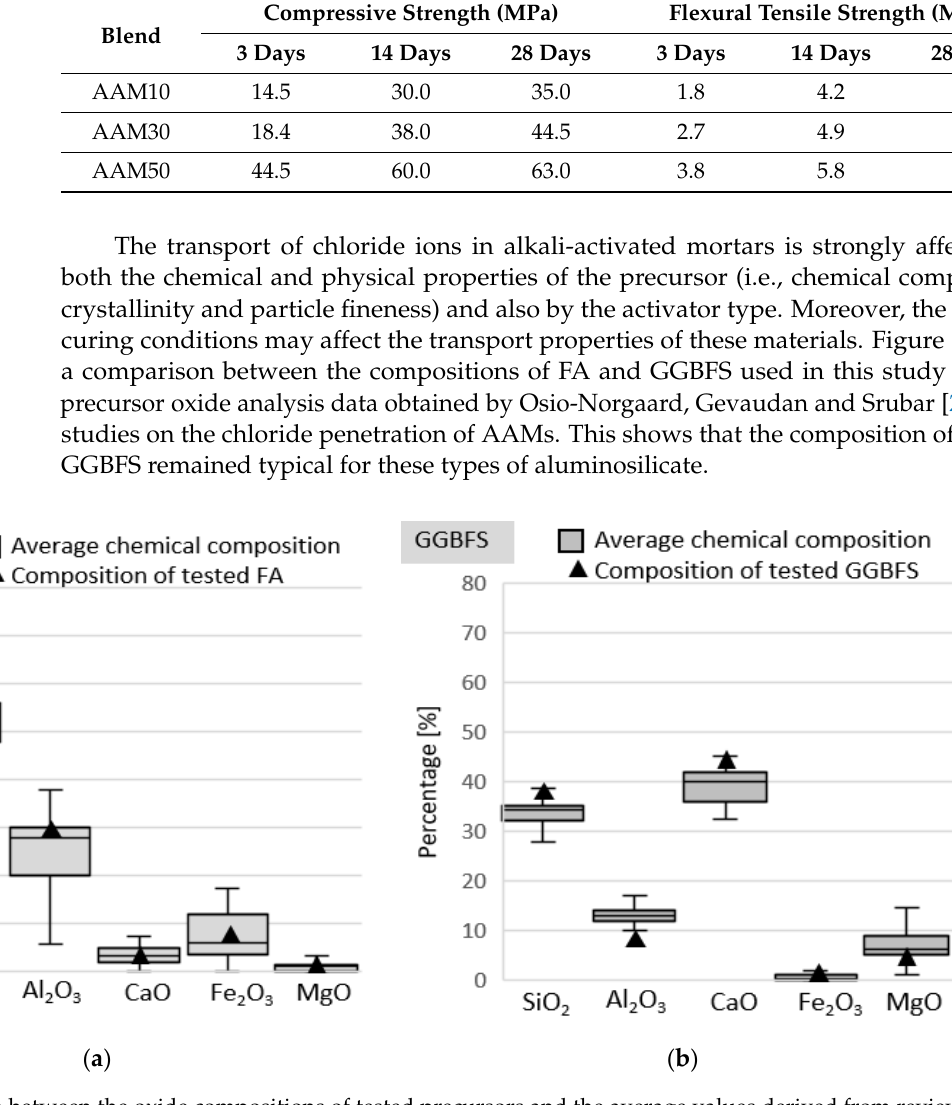
Table 4. Average values of compressive and flexural tensile strength for AAM [8].